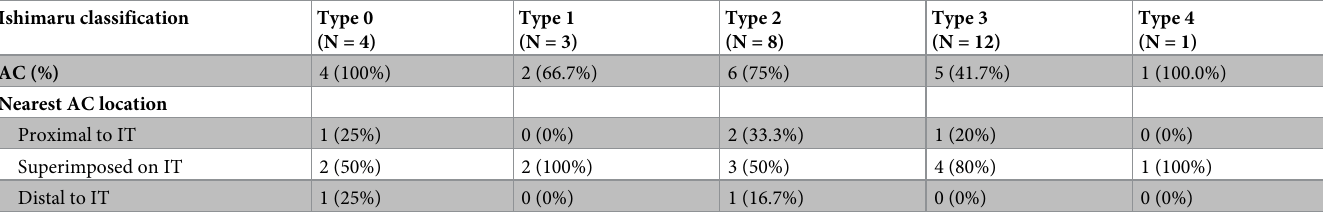
Table 5. The associations between the locations of aortic calcification and the aortic arch zones by the Ishimaru classification. Ishimaru classification